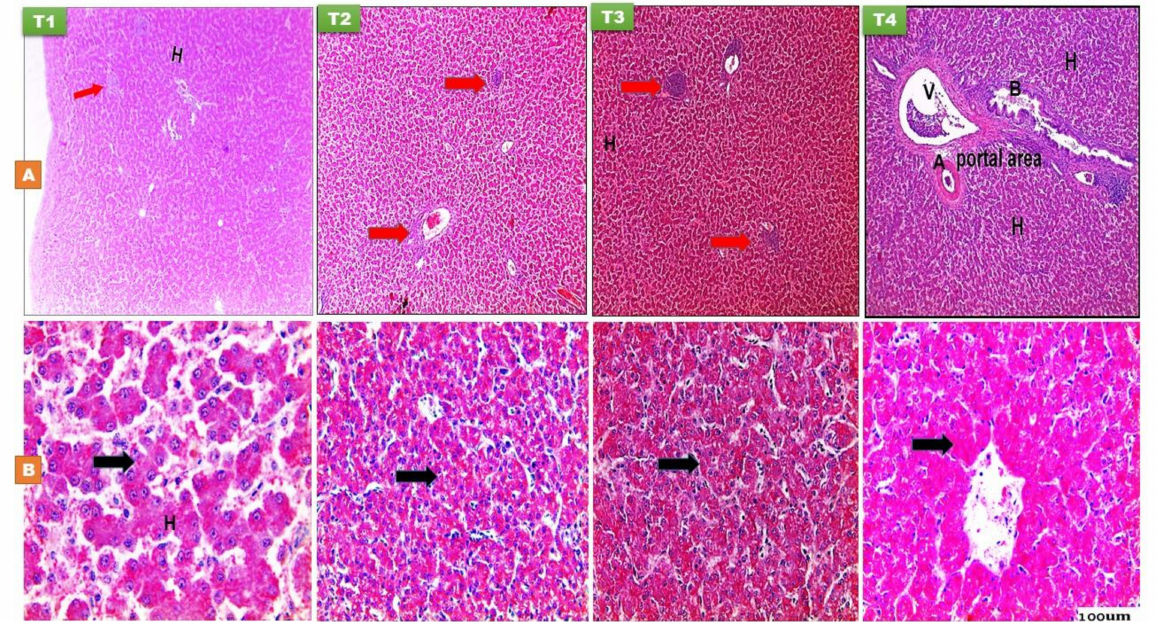
Figure 4. Histological structure of liver at day 14 ( A ) and day 28 ( B ) of age of layer-type chicks exposed to fasting (control, T1) or early feeding on a layer starter diet (T2), a layer starter diet contained 3% molasses (T3), and a broiler starter diet (T4) during the first 72 h post-hatching. Histological examination showed the arrangements of hepatocytes (H) with rounded basophilic nucleus, aggregation of lymph nodules in different area in parenchyma (red arrow) (H and E × 40). Portal area consisted of hepatic portal vein (V), hepatic artery (A), and bile duct (B). The distribution of glycogen granules appeared as reddish dots in the cytoplasm of hepatocytes (black arrow) using Best’s carmine stain ( × 100 and 200).